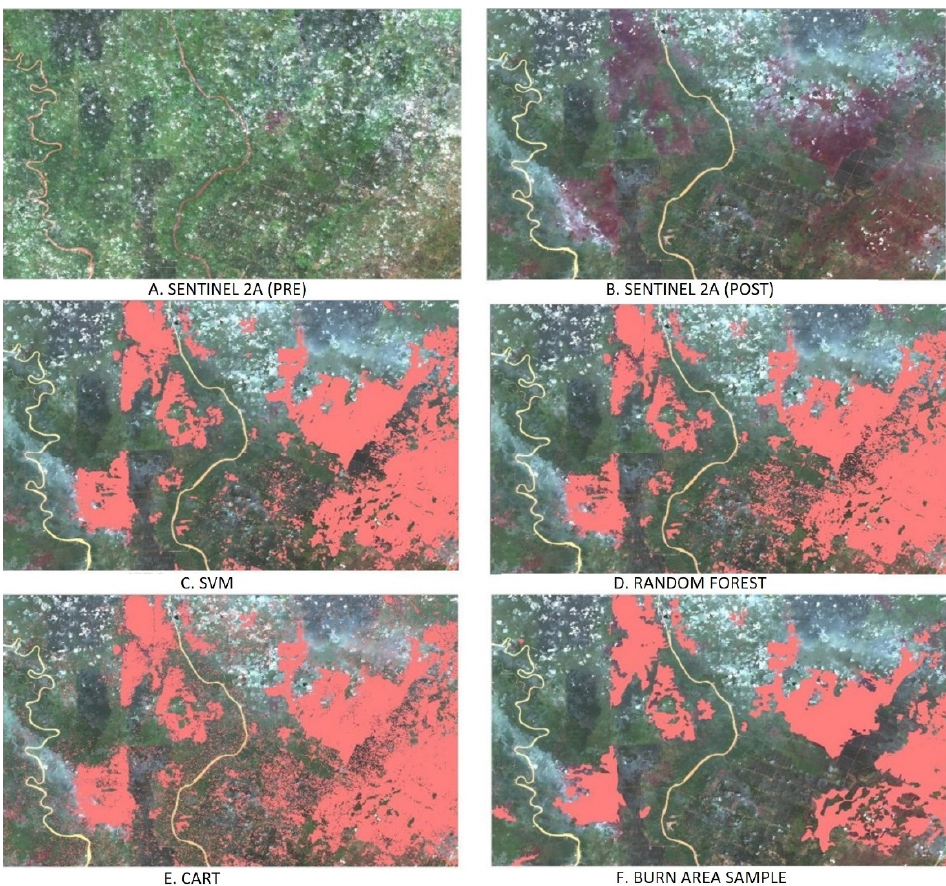
Figure 9. Sentinel-2 image ( A ) before and ( B ) after the fire and the results of the classification ( C ) SVM, ( D ) random forest, ( E ) CART; and ( F ) the distribution of the burnt area from the reference image.